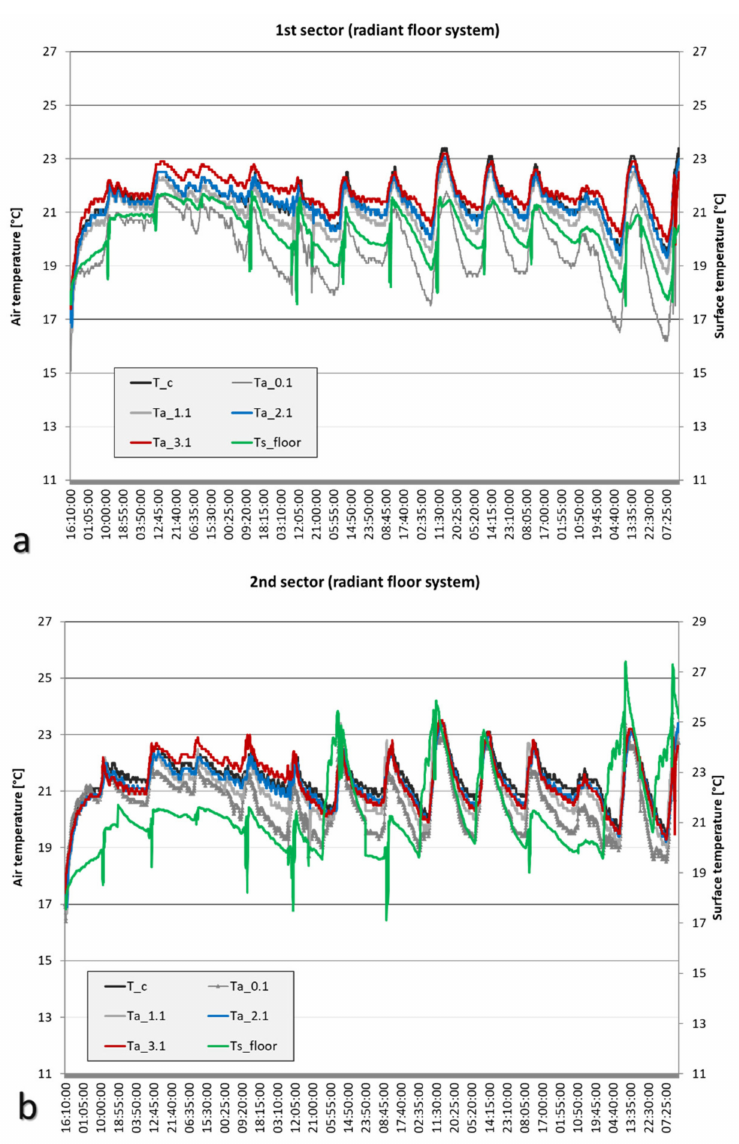
Figure 11. Air temperature at different heights with radiant floor system: ( a ) 1st sector, ( b ) 2nd